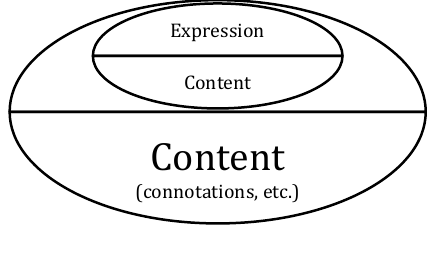
Figure 1. Connotative